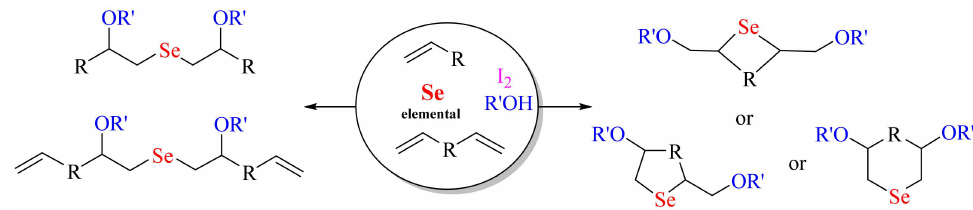
Figure 1. Possible products of alkoxyselenylation of alkenes and